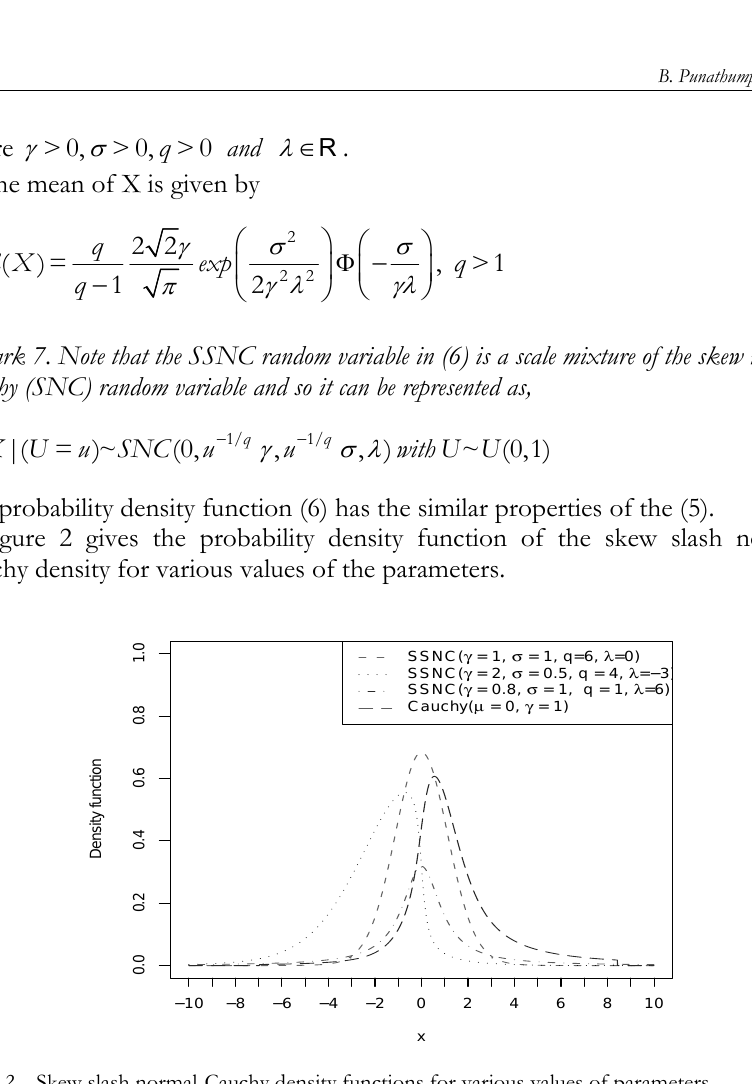
Figure 2 – Skew slash normal-Cauchy density functions for various values of